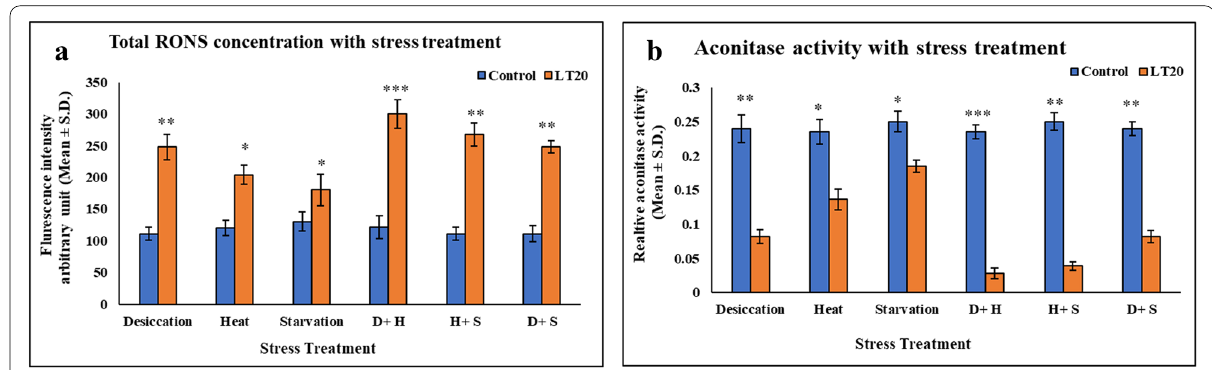
Fig. 6 a Measurement of total reactive oxygen nitrogen species (RONS) fluorescence intensity arbitrary unit (mean SD) b Mitochondrial aconitase ± activity relative to the control with stress treatment (mean SD) in fourth instar larvae of C. ramosus . Values represent mean and the vertical bars ± represent SD. Data shown are representative of three independent experiments. ***P < 0.001; **P < 0.01; *P < 0.05 indicates significance